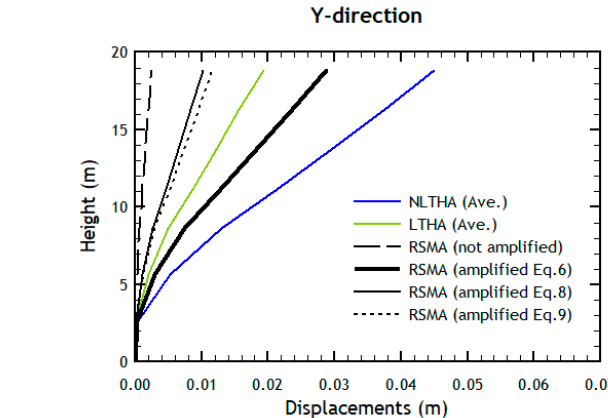
Figure 18. Interstory drifts obtained from the different types of analyses. ASCE-SEI 41-17 (red dashed vertical lines) and ACHISINA limits (purple dash-dot vertical lines) are also plotted. As an instance, a comparison of the top displacement time-histories obtained from the linear and non-linear analysis under one of the most violent earthquakes of the set is shown in Figure 19. The diagrams show a higher displacement demand in the weaker Y